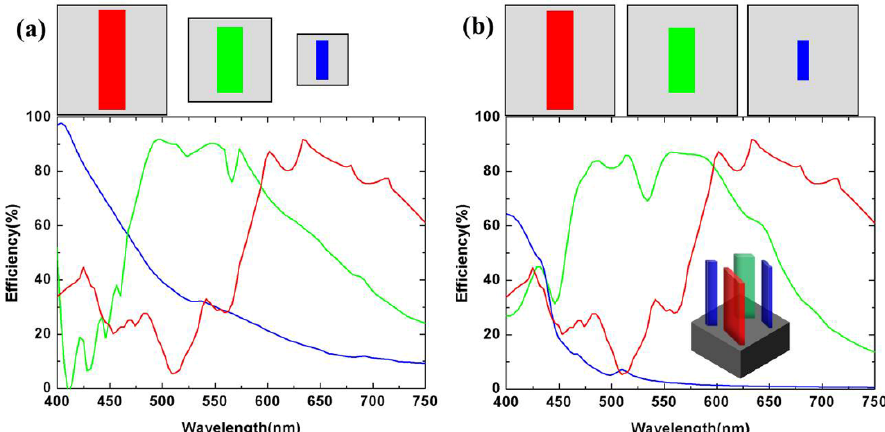
Figure 3. ( a ) The top is the diagram of top view of three nano ‐ pillars (the corresponding sizes are shown in Table 1. The bottom is the simulated polarization conversion efficiency as a function of the wavelength). ( b ) The top is the diagram of the top view of three nano ‐ pillars with the same period as p = 430 nm. The bottom is the simulated polarization conversion efficiency as a function of wavelength. The illustration is a schematic of a complex cell.